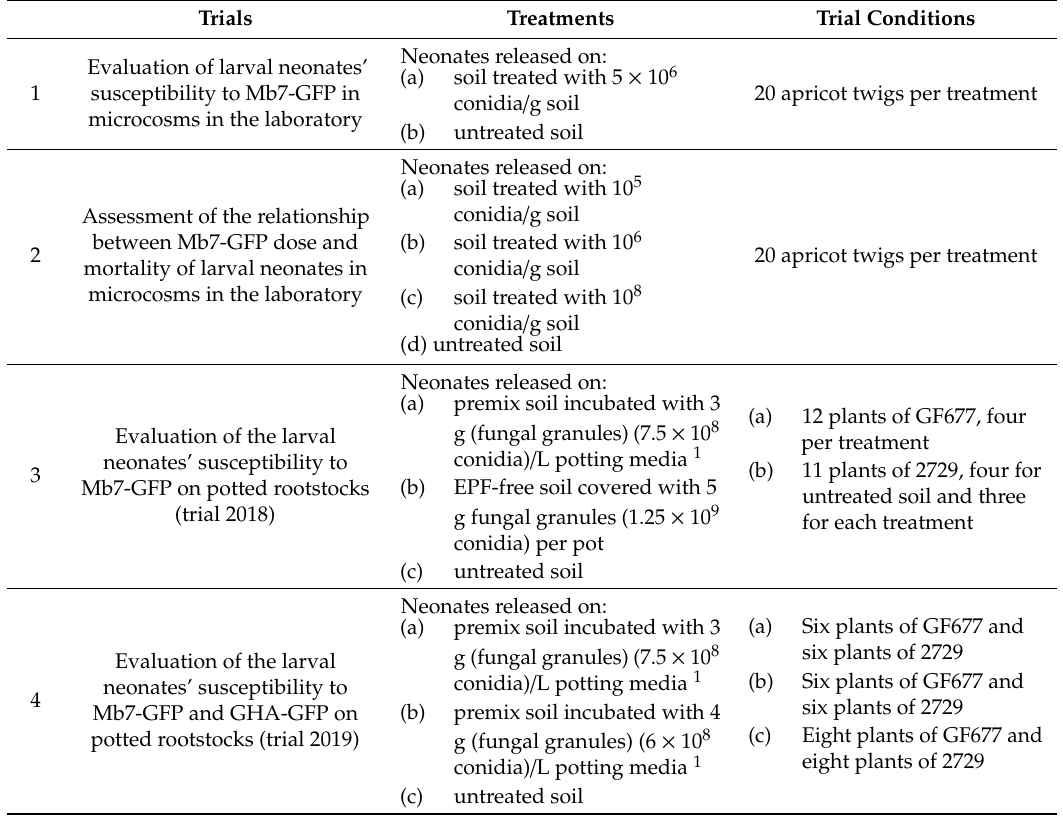
Table 1. Summary of trials carried out in this